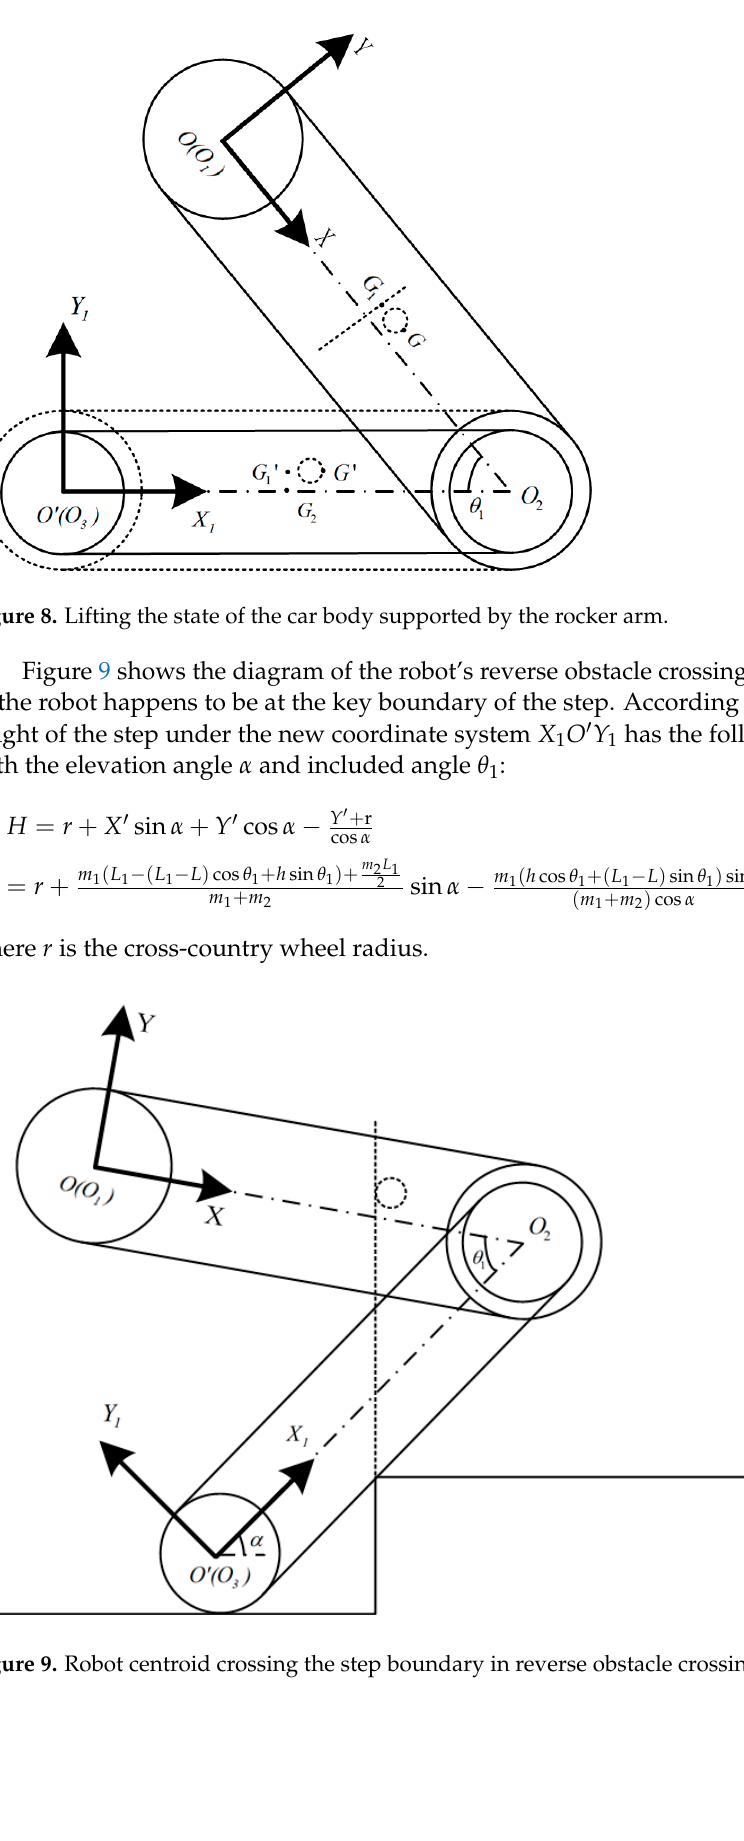
Figure 9. Robot centroid crossing the step boundary in reverse obstacle crossing.